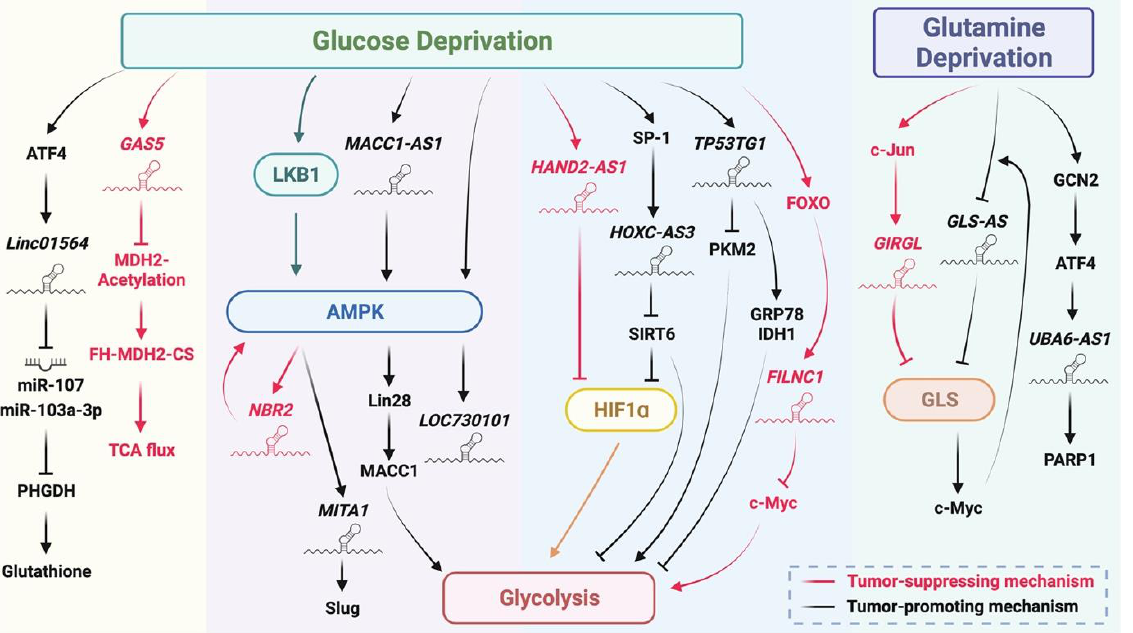
Figure 4. Metabolic stress-responsive lncRNAs are involved in the regulation of cell fate decision under glucose or glutamine deprivation. Glucose starvation induces lncRNA NBR2 , MITA1 , MACC1-AS1 and LOC730101 to participate in the regulatory of AMPK signaling. Another group of lncRNAs, such as HAND2-AS1 and HOXC-AS3 , was upregulated under glucose starvation to modulate glycolysis. On the other hand, glucose deprivation induces GAS5 and Linc01564 to regulate metabolic plasticity in response to stress stimulation. GIRGL , GLS-AS and UBA6-AS1 are shown to be glutamine deprivation-responsive lncRNAs, which regulates glutamine metabolism or maintains PARP1 function to determine cancer cell fate. ATF4 (activating transcription factor 4), PHGDH (phosphoglycerate dehydrogenase), MDH2 (malate dehydrogenase 2), FH (fumarate hydratase), CS (citrate synthase), LKB1 (liver kinase B1), AMPK (AMP-activated protein kinase), MACC1 (metas- tasis-associated in colon cancer protein 1), SP-1 (specificity protein 1), SIRT6 (sirtuin 6), HIF1 ɑ (hy- poxia inducible factor 1 subunit alpha), PKM2 (pyruvate kinase M2), GRP78 (glucose-regulated pro- tein), IDH1 (isocitrate dehydrogenase 1), FOXO (forkhead box O3), GLS (glutaminase), GCN2 (gen- eral control nonderepressible 2) and PARP1 (poly(ADP-ribose) polymerase 1). This figure was cre- ated with BioRender.com.